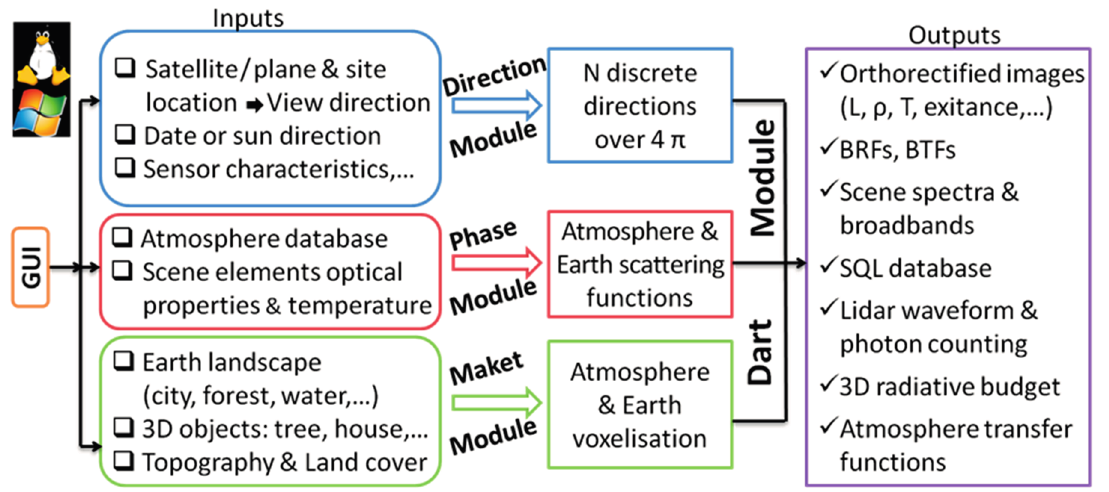
Figure 3. Scheme illustrating DART model architecture: four processing modules (Direction, Phase, Maket, Dart) and input data (landscape, sensor, atmosphere) are controlled through a GUI or pre-programmed scripts. The Sequence module can launch multiple DART simulations simultaneously on multiple processor cores producing effectively several RT